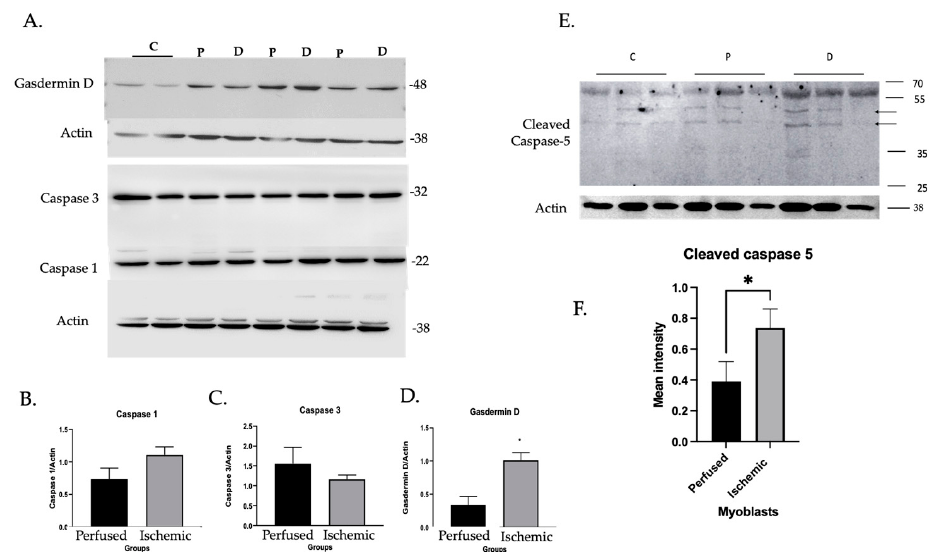
Figure 3. Cleaved caspase-5 and gasdermin D were elevated in ischemic myoblasts. Western blot was performed in perfused (N = 2) and ischemic myoblasts (N = 6) to determine the expression of caspase-1, caspase-3, gasdermin D, and cleaved caspase-5. Actin was used as a loading control. Normalization. kDa are shown. Relative density of each band compared to that of actin and calculated using ImageJ. ( A ) Western blot image of caspase-1, caspase-3, and gasdermin D. ( B ) Quantification of caspase-1 (NS). ( C ) Quantification of caspase-3 (NS). ( D ) Quantification of gasdermin D (* p < 0.03). ( E ) Cleaved caspase-5 Western blot with arrows denoting cleaved products. ( F ) Quantification of cleaved caspase-5 ( p < 0.03, N = 3 perfused, 6 ischemic).